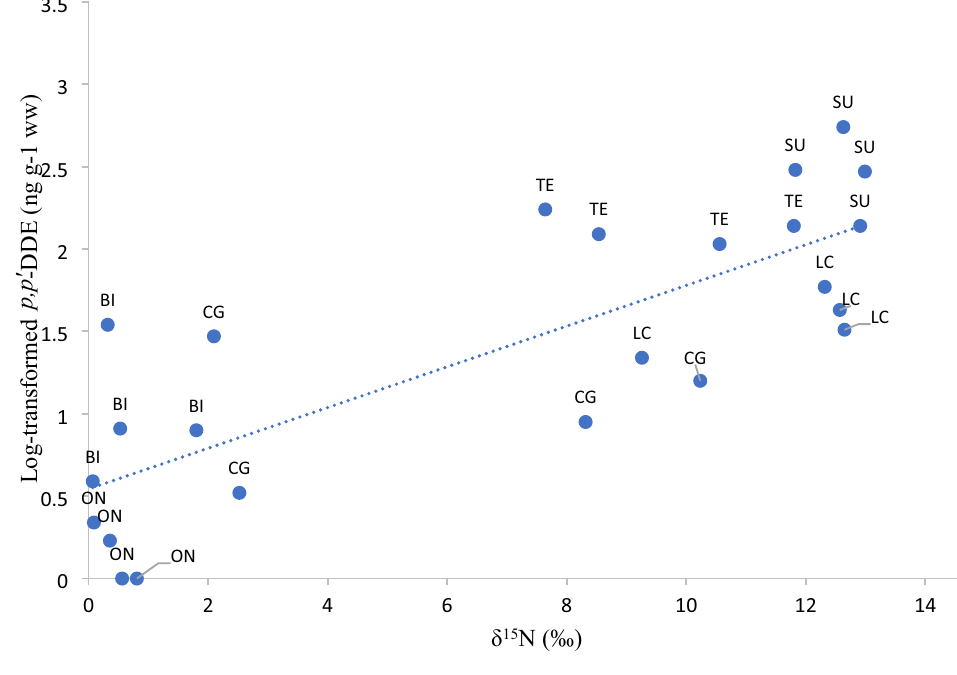
Fig. 5 Regression between log-transformed p,p ’-DDE, and δ 15 N values shows biomagnification of p,p ’-DDE through the local food